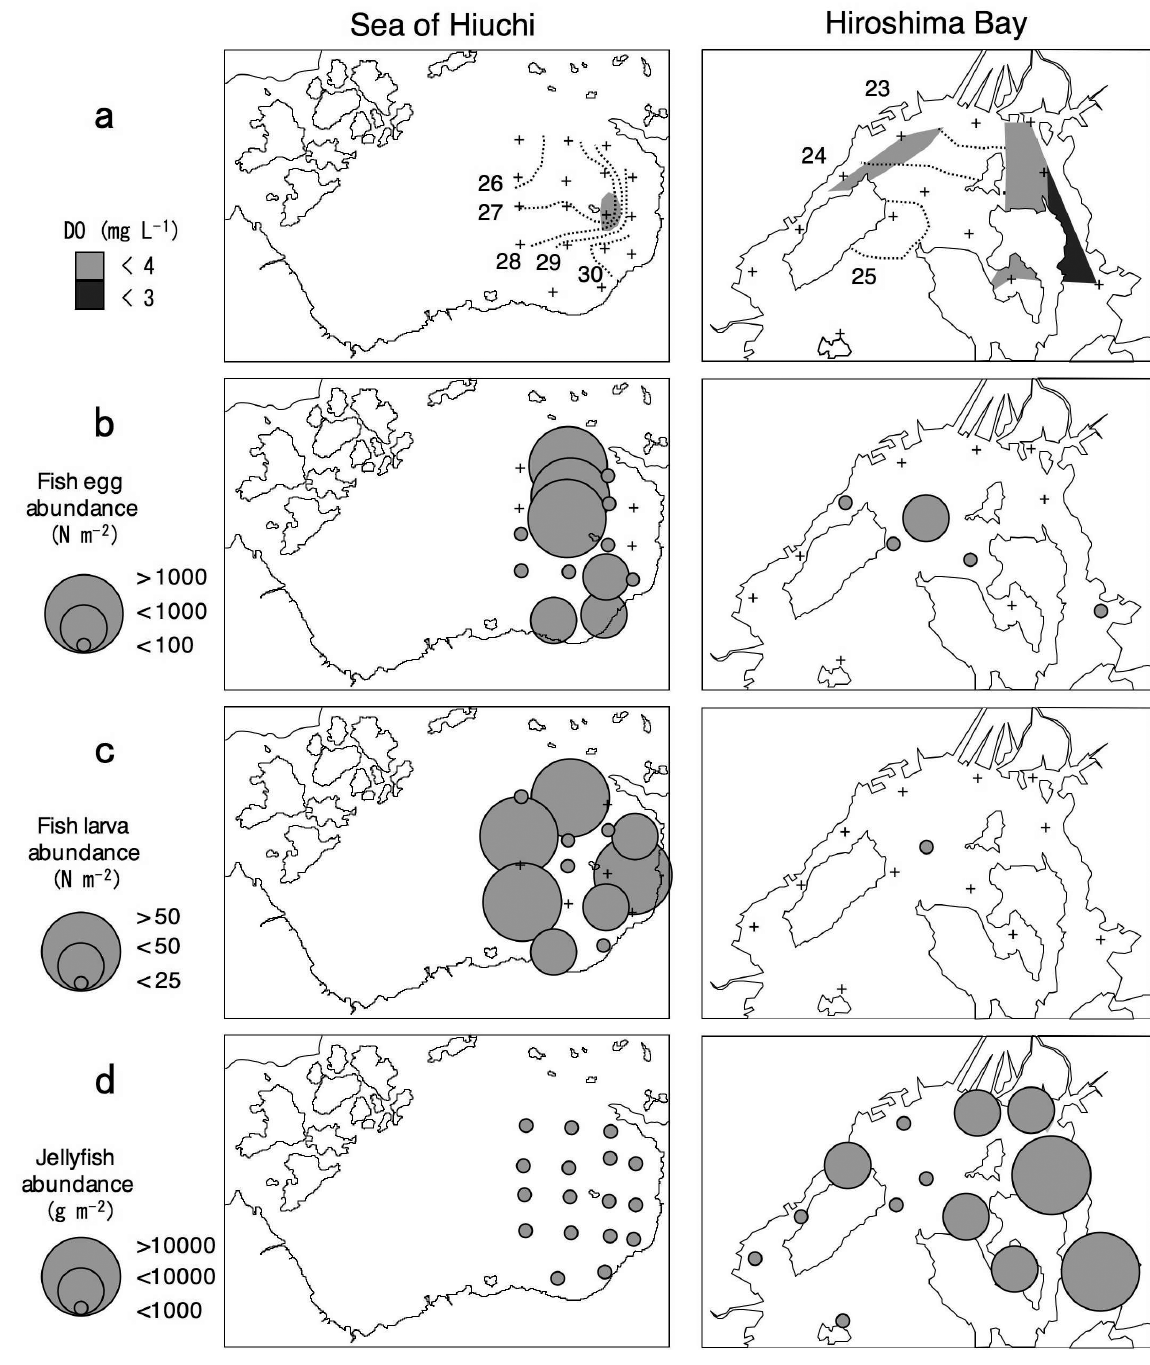
F IG . 3. – Horizontal distribution of sea-surface temperature (°C, contours) and (a) bottom oxygen concentration (DO), (b) fish egg, (c) fish larvae and (d) jellyfish abundance in the Sea of Hiuchi and Hiroshima Bay. Crosses indicate sampled